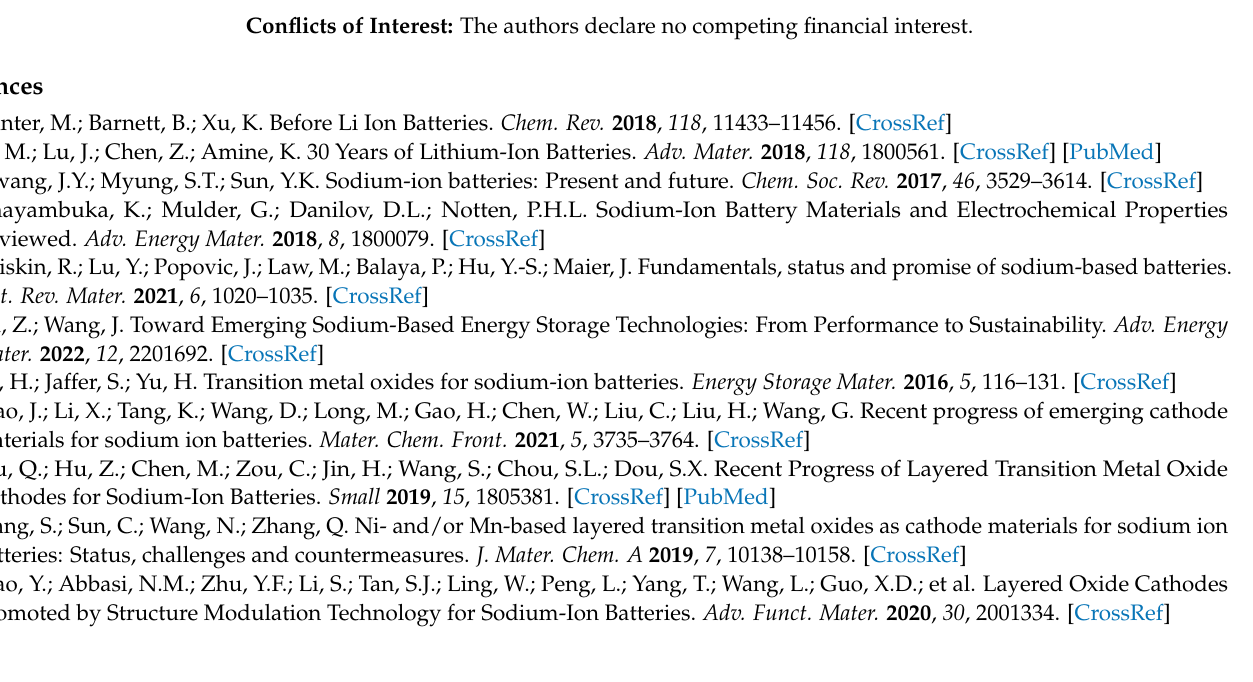
data; Table S1: synthesis recipes; Table S2: XPS analysis results; Table S3: Raman analysis results; Table S4: EIS analysis results